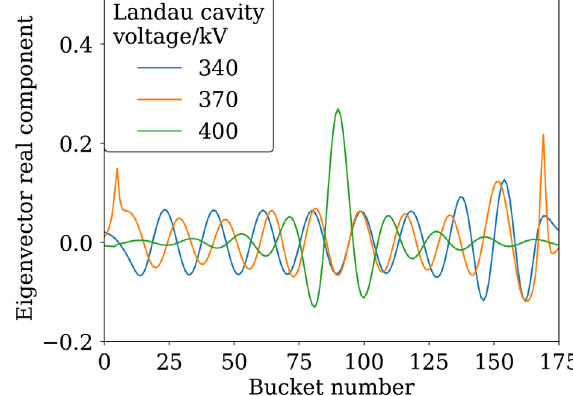
FIG. 10. The real component of normalized eigenvectors that correspond to the least stable coupled-bunch mode at three of the different Landau-cavity voltages that appear in Fig. 9 for the case of two HOMs tuned differently.